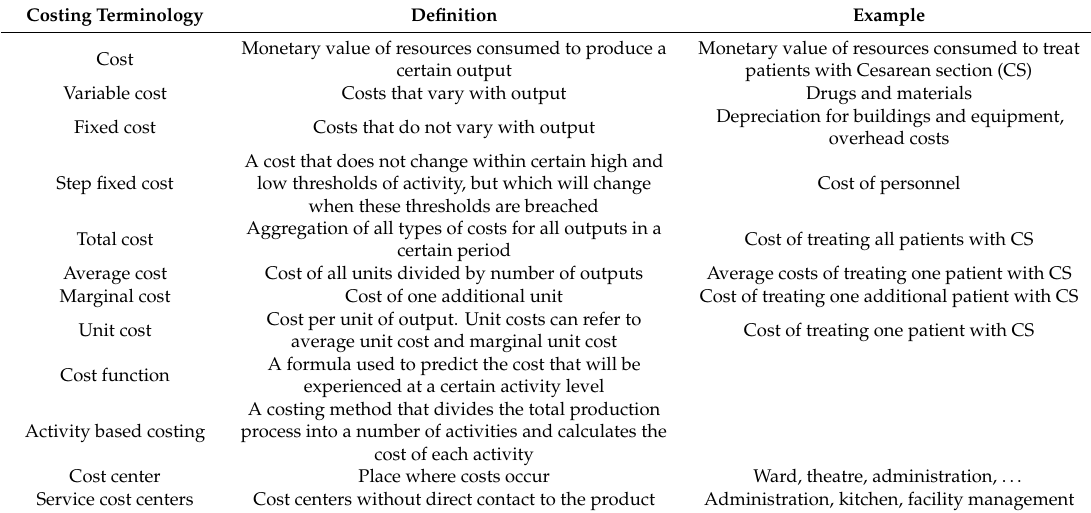
Table 2. Costing terminology